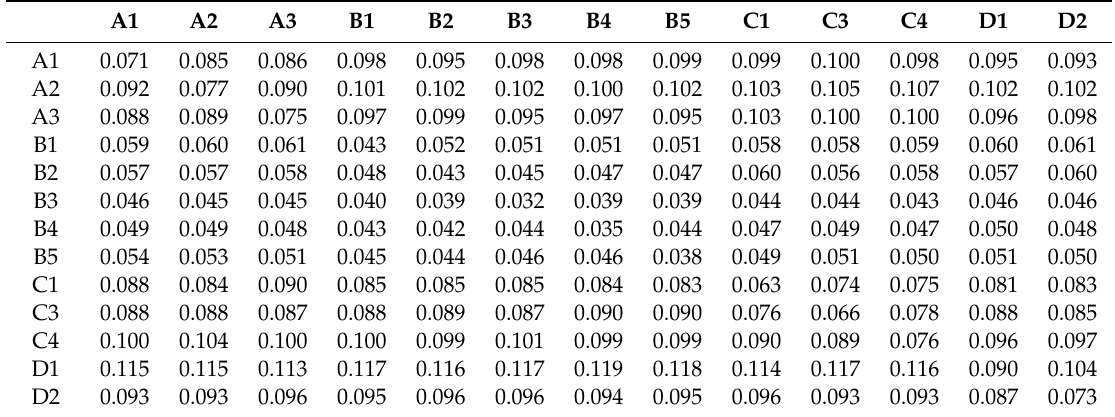
Table 9. Weighted supermatrix W w.